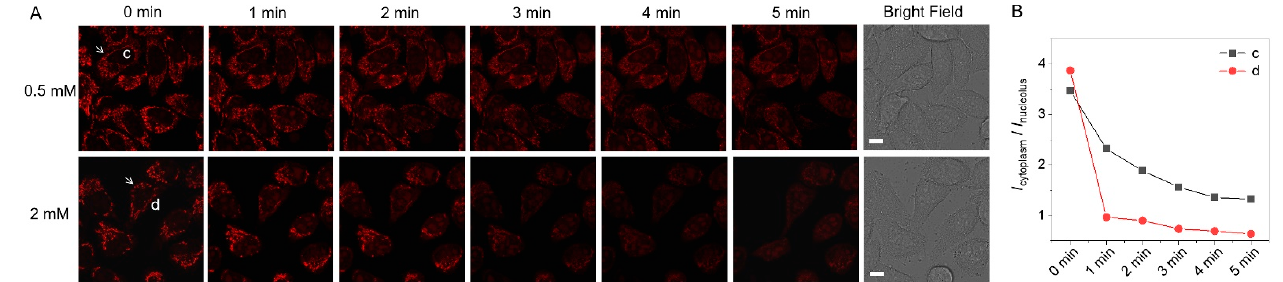
Figure 6. Dynamic MMP monitoring in oxidative environments. ( A ) CLSM imaging of live HeLa cells stained with 10 µM PQ before and after being placed in 0.5 and 2 mM H 2 O 2 for 0–5 min ( λ ex / λ em = 488 nm/550–650 nm, scale bar: 10 µm) and ( B ) corresponding I cytoplasm / I nuleolus changes of the cells “c” and “d” marked by white arrow in ( A ).